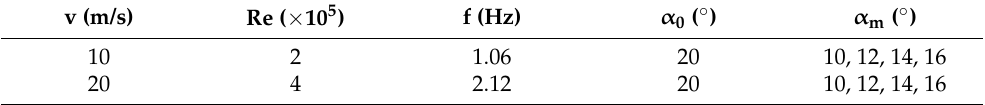
Table 9. Experimental conditions of varying pitch amplitude at different reduced frequencies.